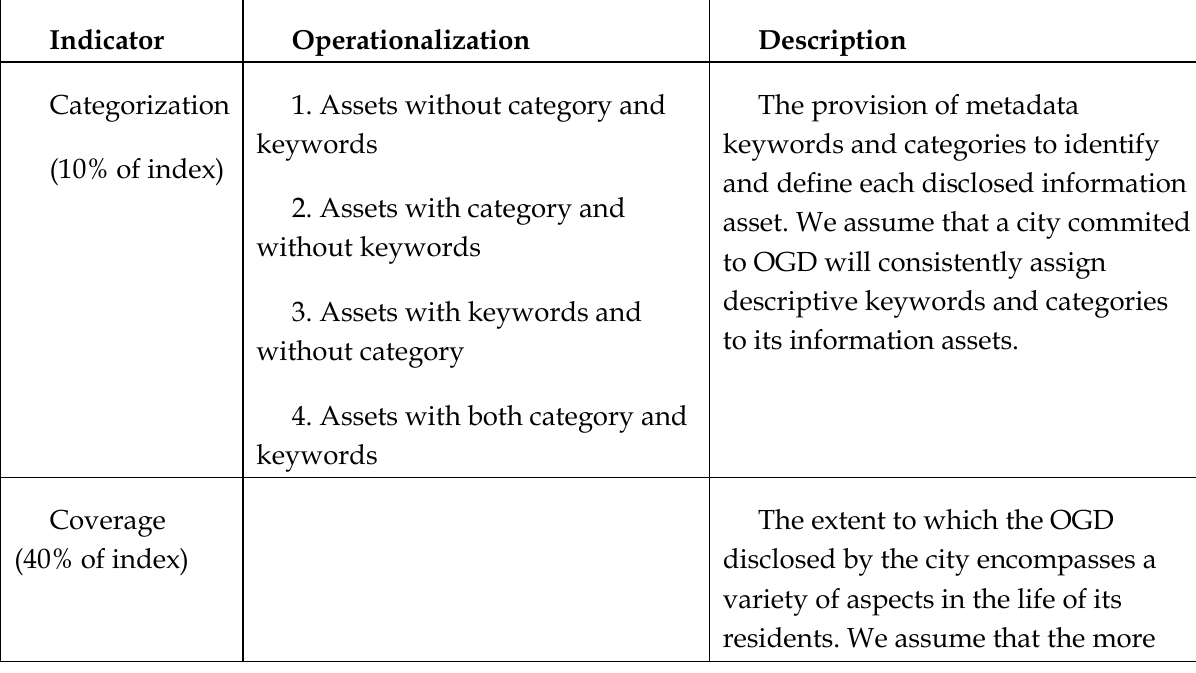
Table 3: Operationalization of the OGD Heartbeat